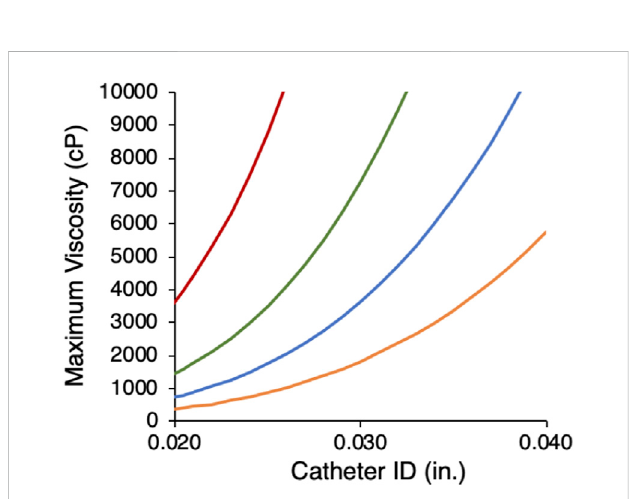
FIGURE 2 Calculated maximum viscosity limits for microcatheters